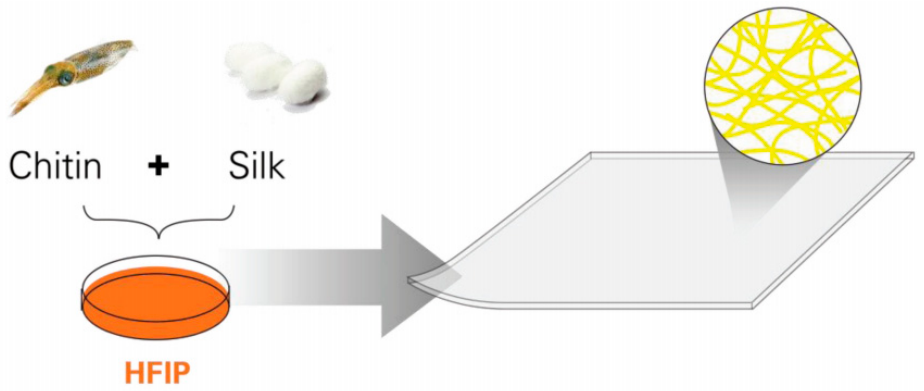
Figure 2. One-step solution based chitin nanofiber silk biocomposite (Reproduced with permission [30]).